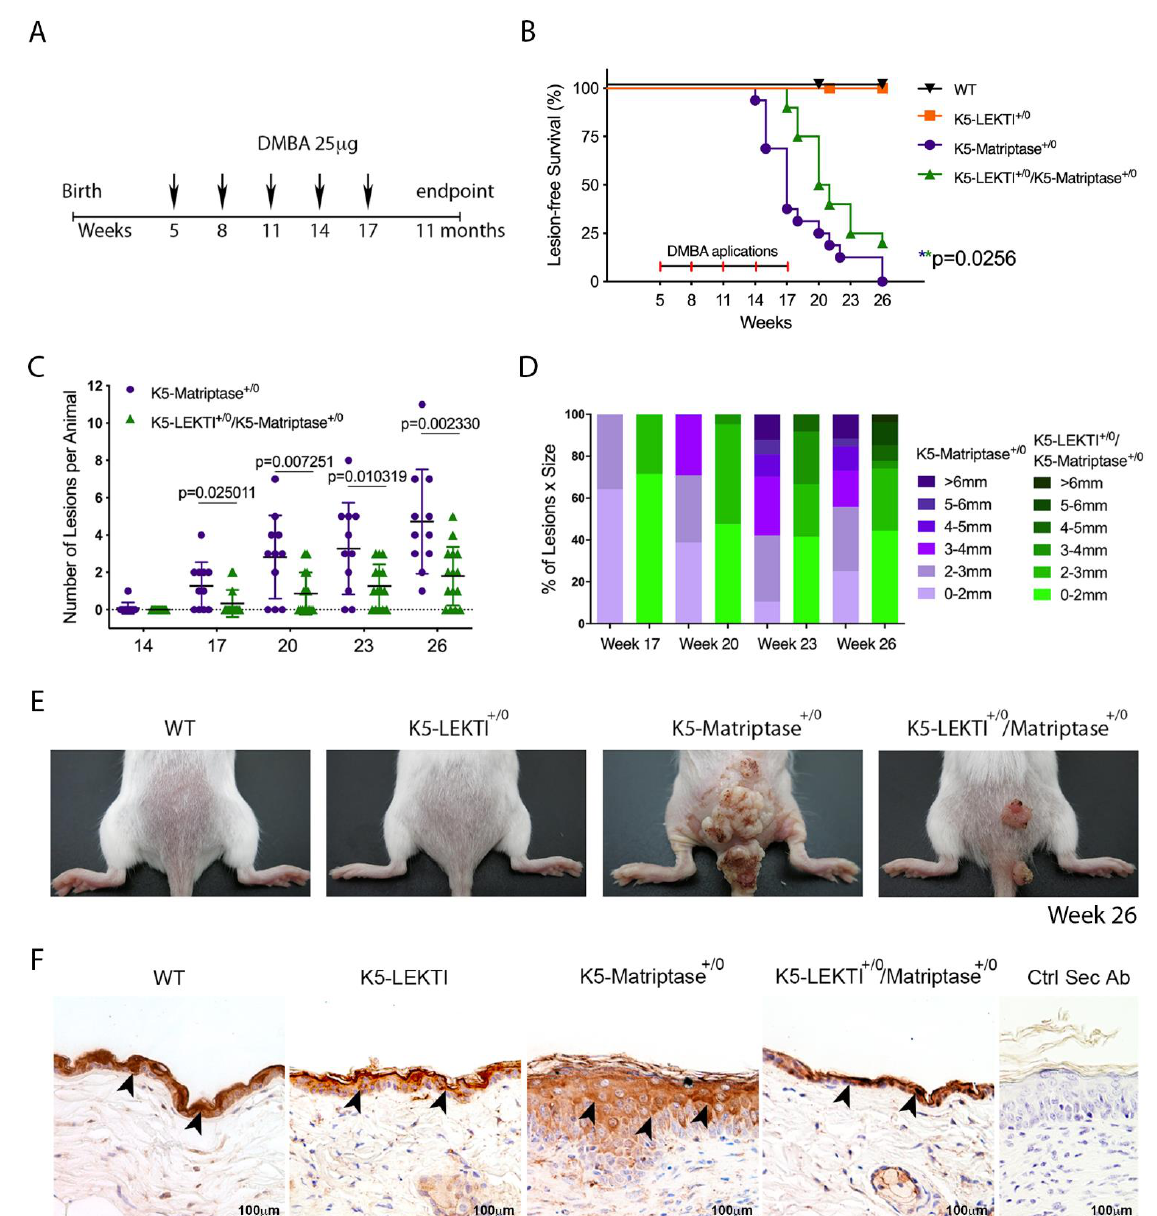
Figure 4. Co-expression of LEKTI with matriptase in basal keratinocytes delays the onset and progression of chemically induced carcinogenesis. ( A ) One-stage chemical carcinogenesis scheme: dorsal skin of mice was exposed 5 times to 25 μg of DMBA, starting at week 5 of age, every 3 weeks, and were followed for up to 48 weeks of age. WT ( n = 20), K5-LEKTI +/0 ( n = 17), K5-Matriptase +/0 ( n = 11), and K5-Matriptase +/0 /K5-LEKTI +/0 ( n = 16). ( B ) Kaplan–Meier analysis of tumor-free survival. WT (black upside-down triangle), K5-LEKTI +/0 (orange squares), K5-Matriptase +/0 (purple dots), and K5-Matriptase +/0 /K5-LEKTI +/0 (green triangles). ( C , D ) Matriptase induced tumor progression in K5-Matriptase +/0 , and K5-Matriptase +/0 /K5-LEKTI +/0 mice. Data are expressed in mean ± SD. ( C ) number of lesions and ( D ) percentage of lesion of each size in littermate K5-Matriptase +/0 (purple dots) and K5-Matriptase +/0 /K5-LEKTI +/0 (green triangles) mice from 14 to 26 weeks of age. p -values (multiple t -tests) are displayed in the graphs. (E) Representative images of the outward appearance of littermate WT, K5-LEKTI +/0 , K5-Matriptase +/0 , and K5-Matriptase +/0 /K5-LEKTI +/0 mice at 26 weeks of age. ( F ) Klk5 IHC staining of the skin of 3-month-old WT, K5-LEKTI +/0 , K5-Matriptase +/0 , and K5-Matriptase +/0 /LEKTI +/0 mice. Black arrowheads indicate stained areas; Negative secondary antibody control; Bar = 100 µ